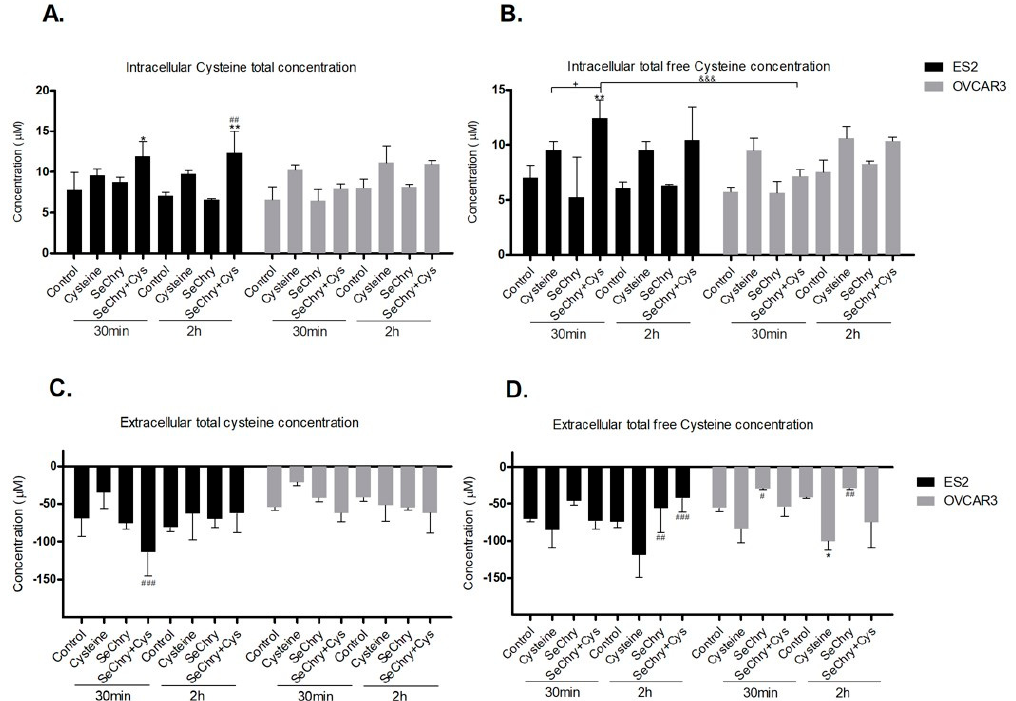
Figure 3. SeChry does not impair cysteine uptake. ES2 and OVCAR3 cell lines were exposed to DMSO (control), cysteine, SeChry, and SeChry combined with cysteine. After 24 h of SeChry exposure, cells were incubated with cysteine for 30 min and 2 h. High-performance liquid chromatography (HPLC) coupled to fluorescence detection (FLD) was used to measure ( A ) intracellular total cysteine concentration, ( B ) intracellular total free cysteine concentration, ( C ) total cysteine concentration in